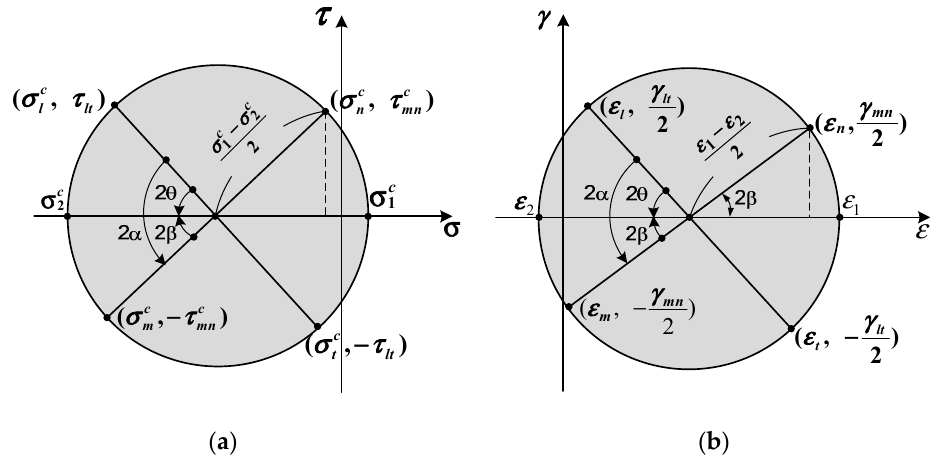
Figure 3. Mohr’s stress and strain circles: ( a ) Mohr’s stress circle; ( b ) Mohr’s strain circle.